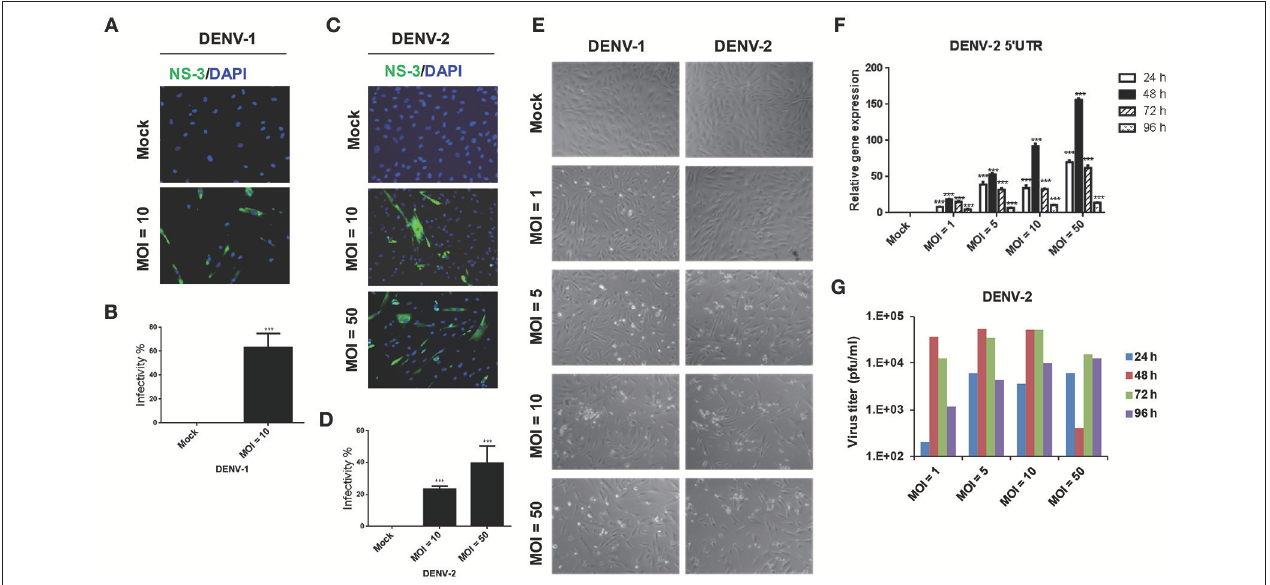
FIGURE 1 | Infective ability of dengue virus type 1 (DENV-1) and DENV-2 in hair follicle dermal papilla cells (HFDPCs). (A,C) Immunofluorescence assay of HFDPCs with DENV-1 (MOI = 10) and DENV-2 (MOI = 10 and 50) infection for 4 days. Shows NS3 protein signal (green fluorescence) of DENV infection and DAPI staining (blue fluorescence) for cell nuclei. (B,D) Quantification of the DENV-1 and DENV-2 infectivity in HFDPCs. Data are mean ± SD of three observation fields. *** P < 0.005 vs. untreated control. (E) The cell morphology of HFDPCs with DENV-2 infection (MOI = 1, 5, 10, and 50) for 72h under brightfield microscope were observed and captured. (F) RT-qPCR of DENV-2 5 ′ -UTR expression in HFDPCs infected with DENV-2 (MOI = 1, 5, 10, and 50) were performed at 24, 48, 72, and 96h postinfection. The gene expression was normalized to GAPDH gene. Data are mean ± SD from three independent tests, *** P < 0.005 vs. untreated control. (G) Detection of DENV-2 virions in the growth medium of HFDPCs. The growth medium of HFDPCs with DENV infection (MOI = 1, 5, 10, and 50) were harvested at 24, 48, 72, and 96h postinfection by virus titration plaque assay in BHK-21 cells.